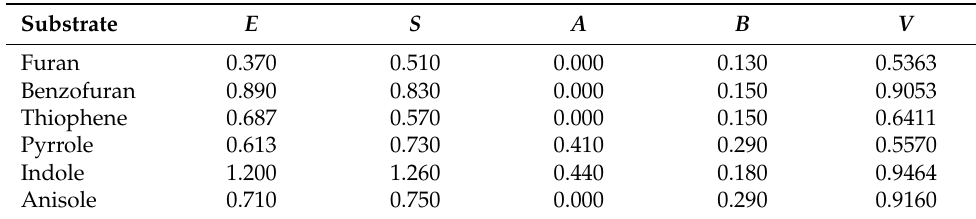
Table 4. Substrate descriptors used in this work [25].